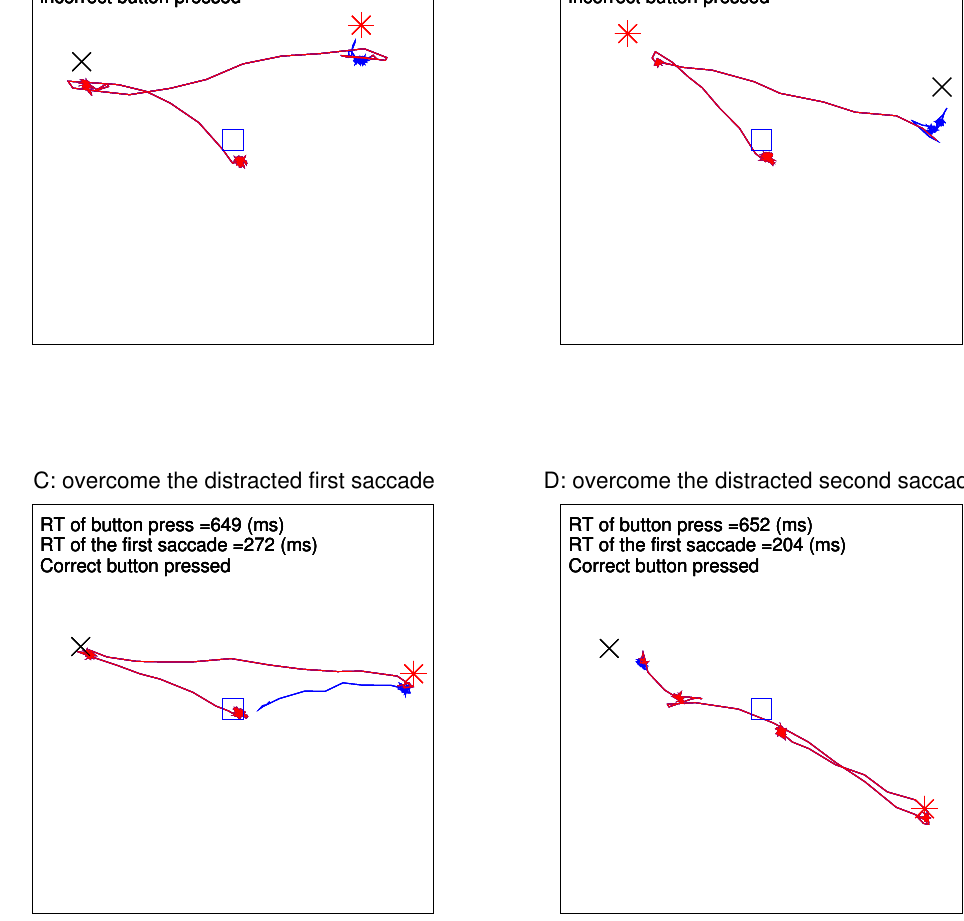
Figure 4. Gaze traces in four example DI trials (of Experiment 2), when an observer searched for an orientation singleton bar in the presence of a distracting ocularity singleton in the search array. Each box frames the region of the perceived visual field containing the array of bars. The locations of the central fixation point (before the stimulus onset), the target, and the distracting ocularity singleton are marked by the blue (cid:3) , the red , and the black , respectively. The red and blue traces are gaze ∗ × trajectories before and after the button press, respectively. In each frame, the RT of the first saccade during the search, the RT of the button press, and whether the correct or incorrect button was pressed are